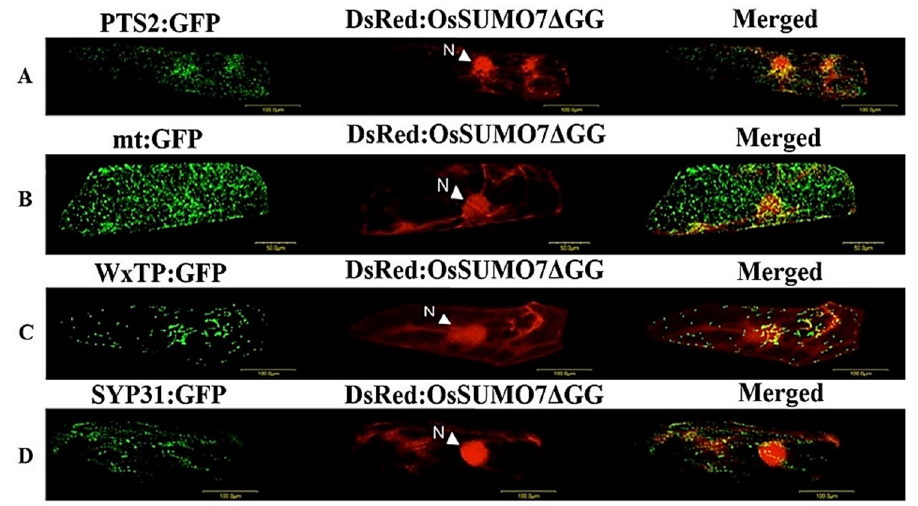
Figure 7. ( A ) Co-expression of DsRed:OsSUMO7 Δ GGs and PTS2:GFP in onion cells. PTS2 peroxisomal marker. ( B ) Co-expression of DsRed:OsSUMO7 Δ GGs and mt:GFP in onion cells. mt; mitochondrial marker. ( C ) Co-expression of DsRed:OsSUMO7 Δ GGs and WxTP:GFP in onion cells. WxTP, plastidial marker. ( D ) Co-expression of DsRed:OsSUMO7 Δ GGs and SYP31:GFP in onion cells. SYP31, cis-Golgi marker.